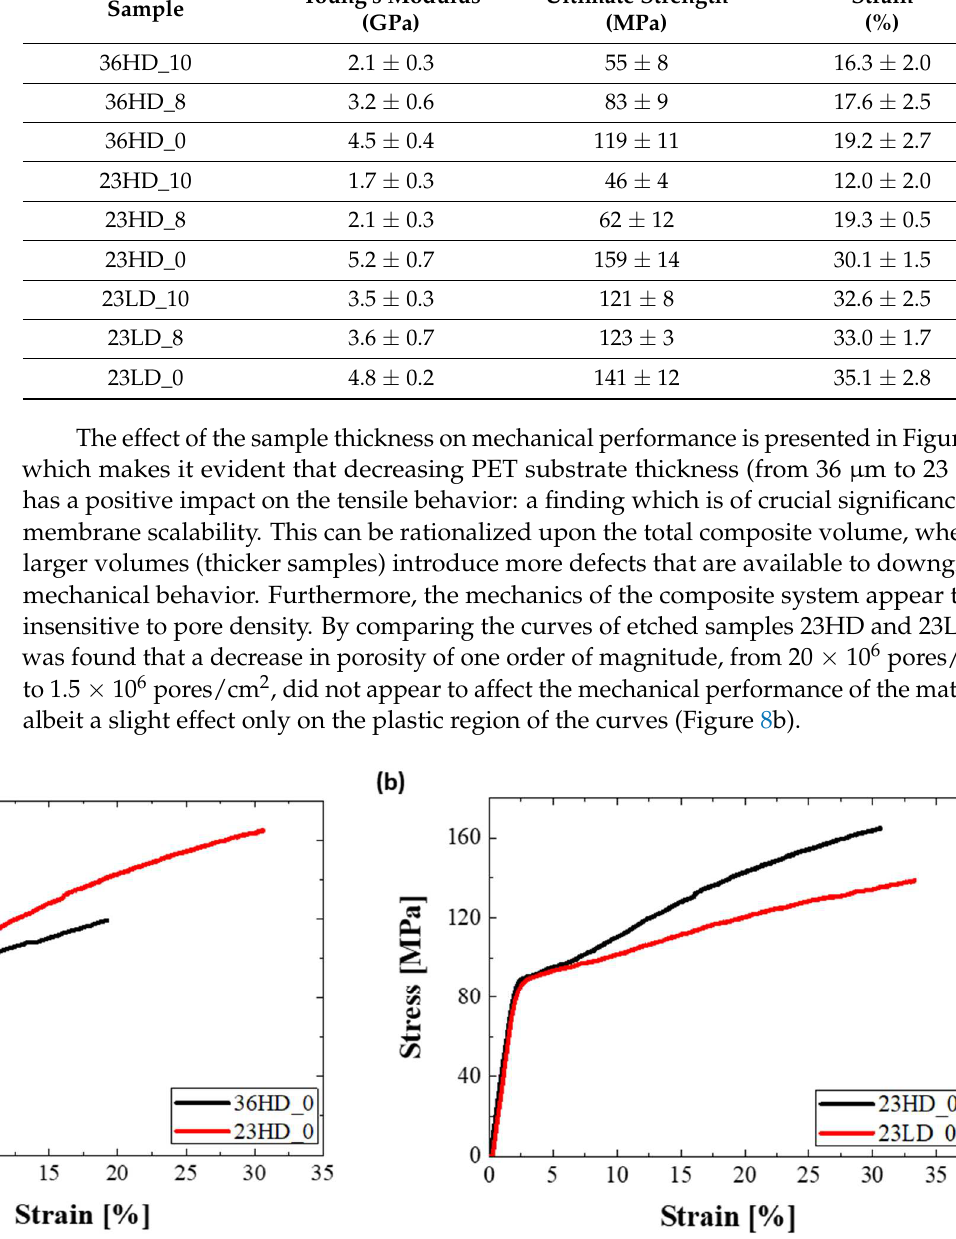
Table 2. Engineering property values extracted from the stress–strain curves. Sample